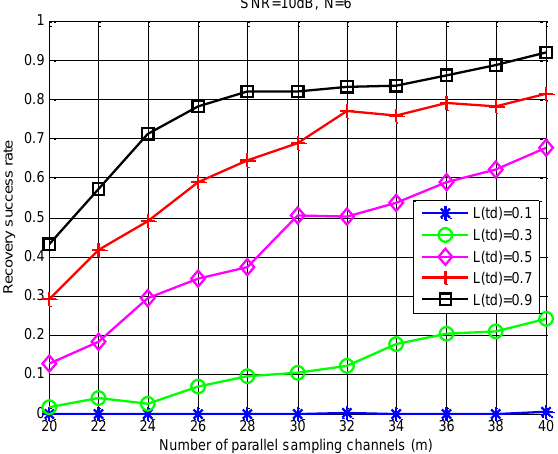
Figure 8. Influence of the sampling channels number on recovery accuracy under different loss gains.